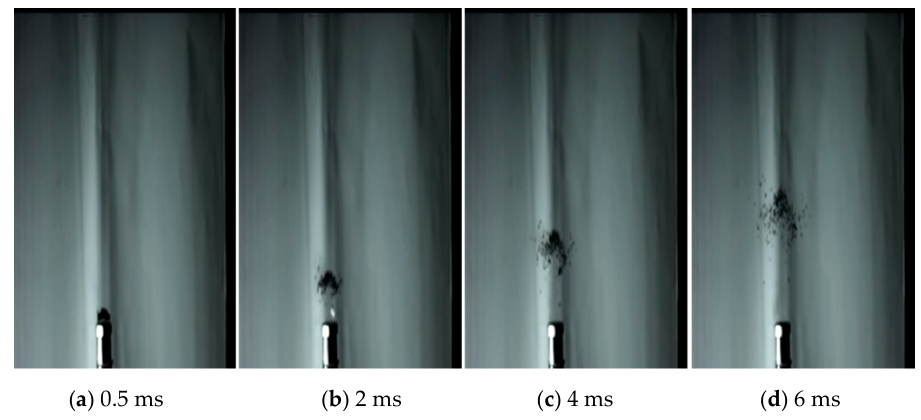
Figure 6. The dispersion process of the quartz sand particles with an average diameter of 2.5 mm during the experiment. ( a ) at 0.5 ms; ( b ) at 2 ms; ( c ) at 4 ms; ( d ) at 6 ms.